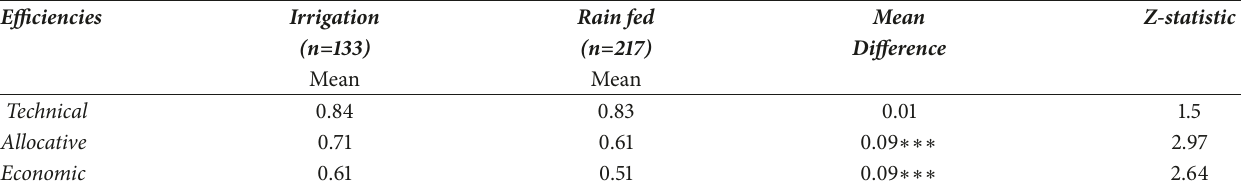
Table 6: Mean differences of irrigation and rain fed farms.